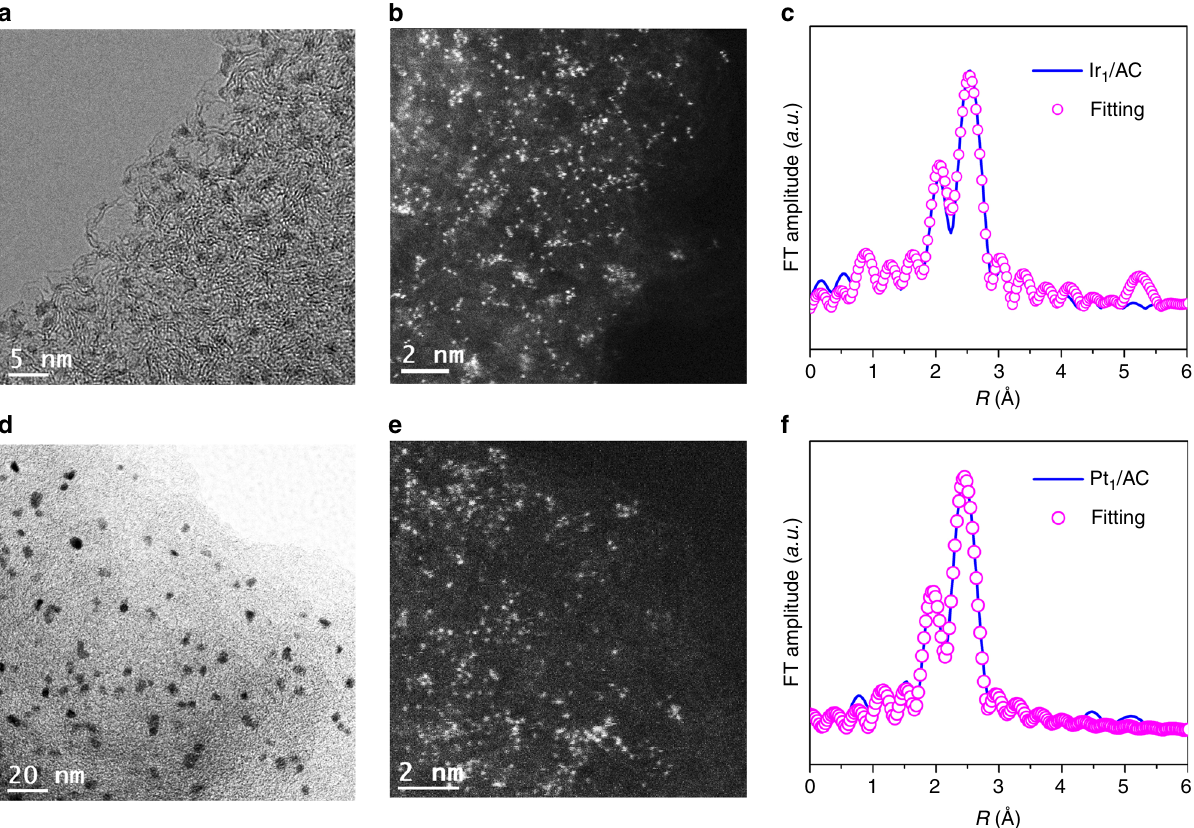
Fig. 5 Atomic dispersion of supported Ir and Pt NPs. a The HRTEM image of Ir/AC; b the HAADF-STEM image of Ir 1 /AC; c comparison of the experimental (solid line) and fi tted (dashed line) curve of k 2 -weight EXAFS spectra of Ir 1 /AC catalyst. d The HRTEM image of Pt/AC; e the HAADF-STEM image of Pt 1 / AC; f comparison of the experimental (solid line) and fi tted (dashed line) curve of k 2 -weight EXAFS spectra of Pt 1 /AC